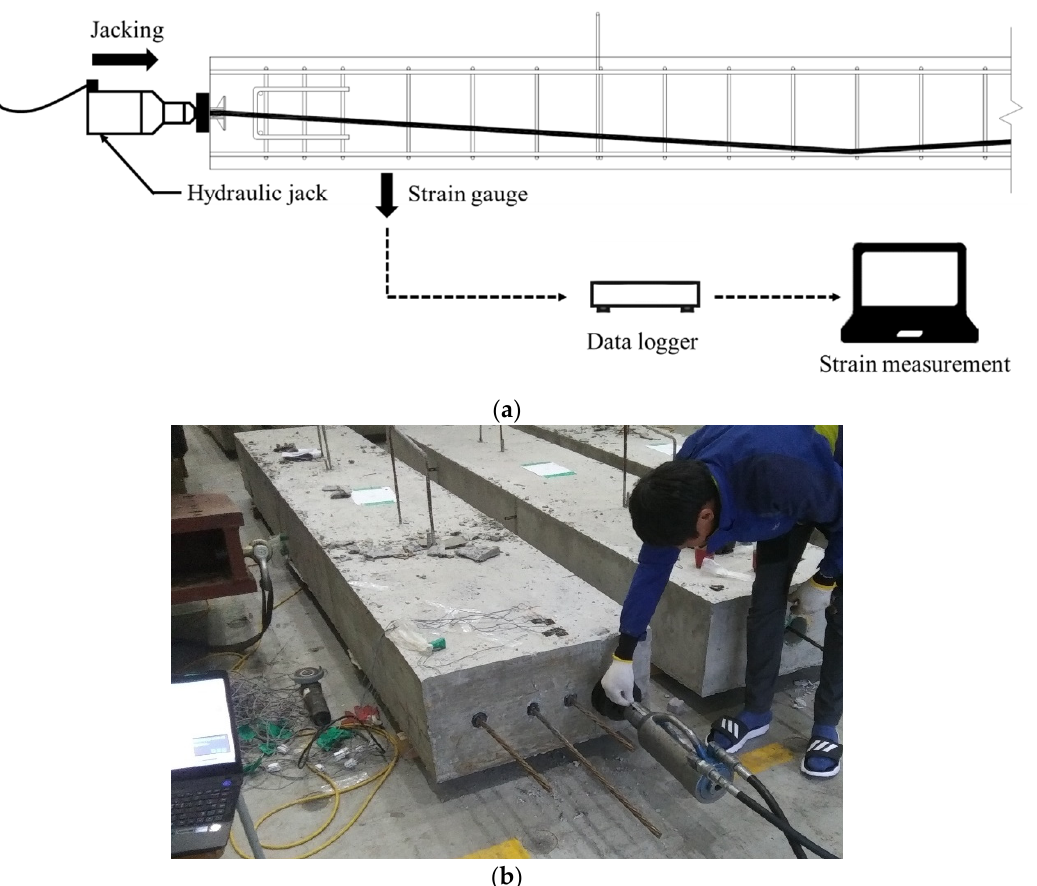
Figure 5. Test setup at the jacking stage: ( a ) schematic test setup; ( b ) photograph of test setup.